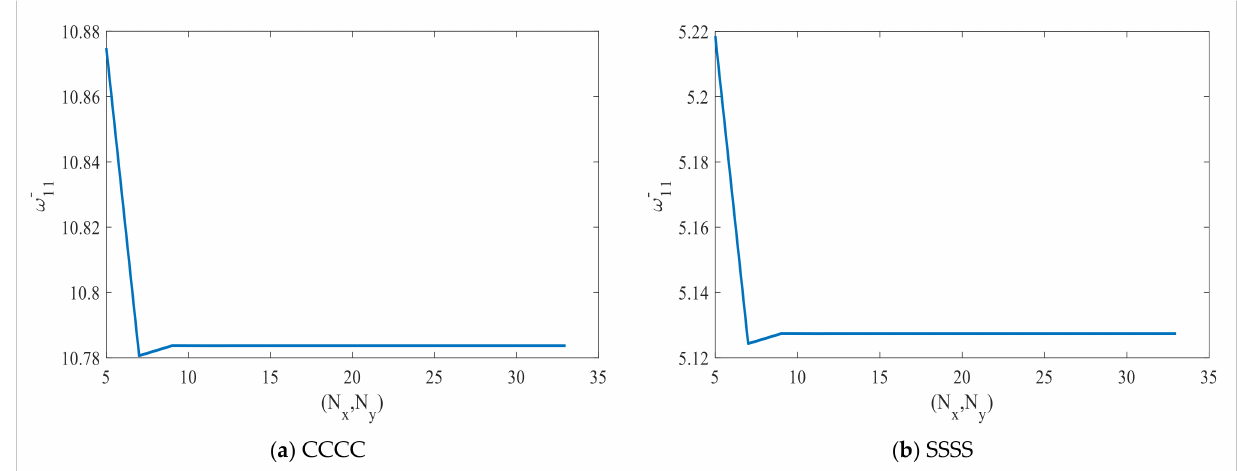
Figure 4. Convergence study of the first fundamental frequency, when assuming a GPL-UD, b / a = 5, a / h = 10, and Λ = 0.5%: ( a ) CCCC boundary conditions, ( b ) SSSS boundary GPL